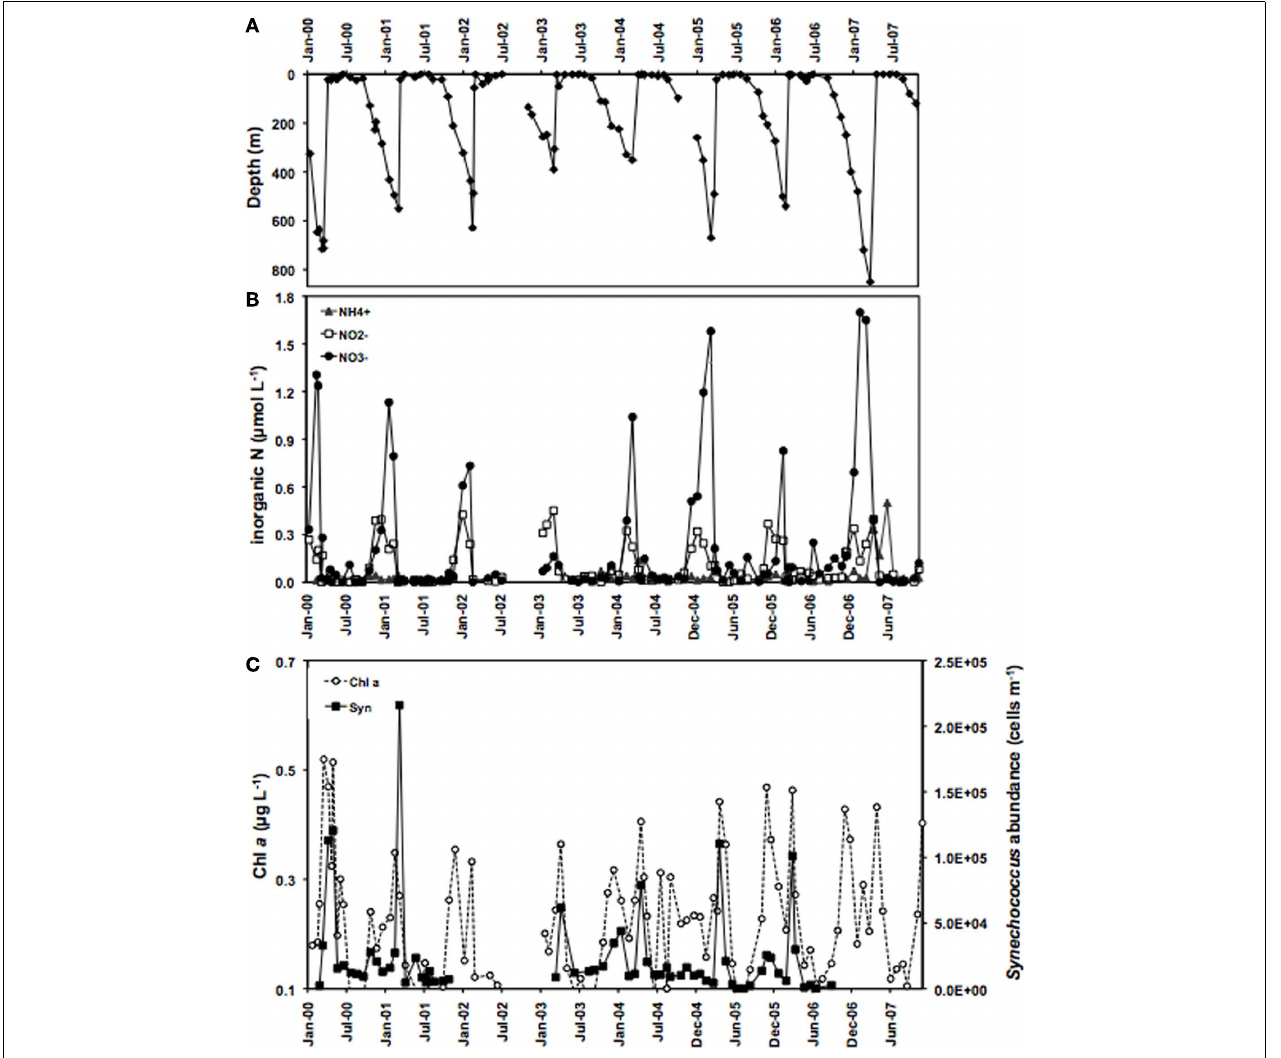
FIGURE 3 | Overview of (A) mixing depth, (B) nitrite, nitrate, and ammonium concentrations at 20m depth and (C) chlorophyll a concentrations and Synechococcus cell numbers at 20m depth at sampling stationA in open waters of the Gulf ofAqaba between 2000 and